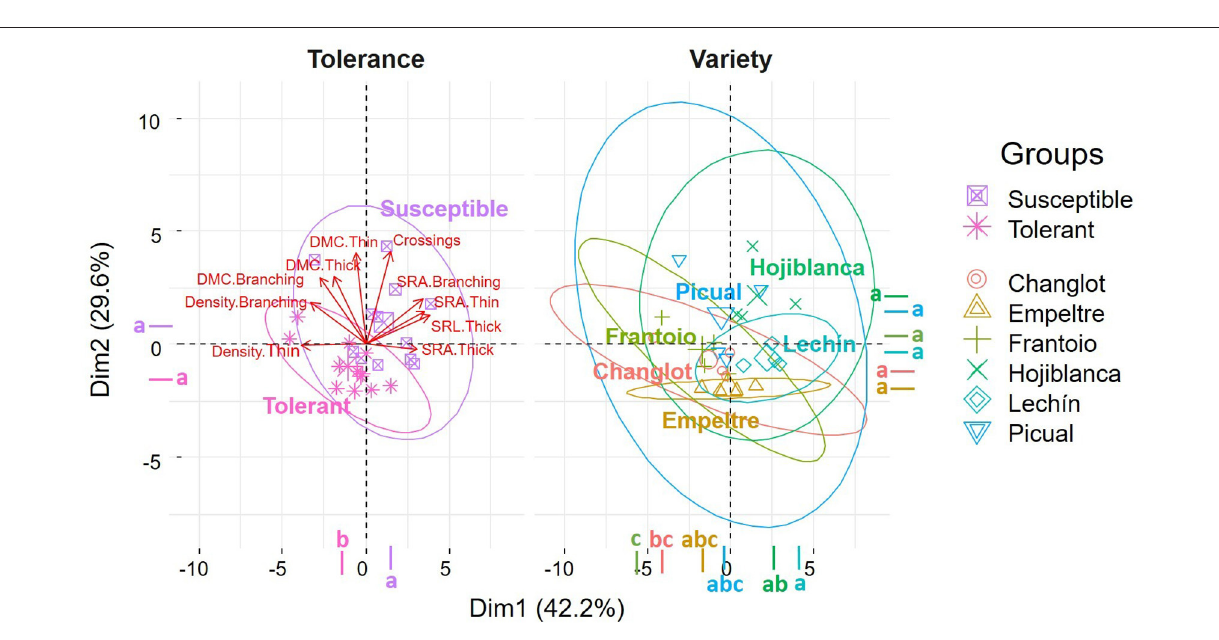
Regarding the first group of genes, β -1,3-glucanase